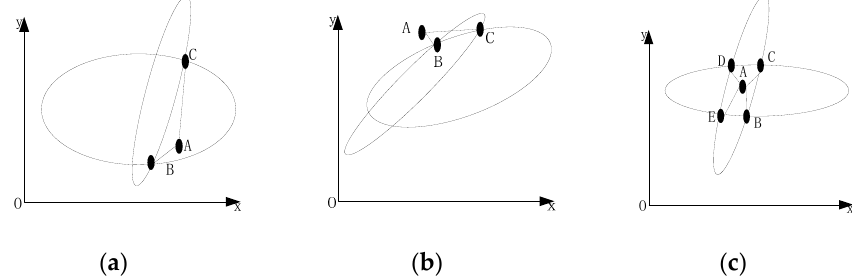
Figure 5. Principle of filtering ambiguous solutions: ( a ) coordinate x of ambiguous solutions closer to original star point; ( b ) coordinate y of ambiguous solutions closer to original star point; ( c ) all ambiguous solutions almost close to original star